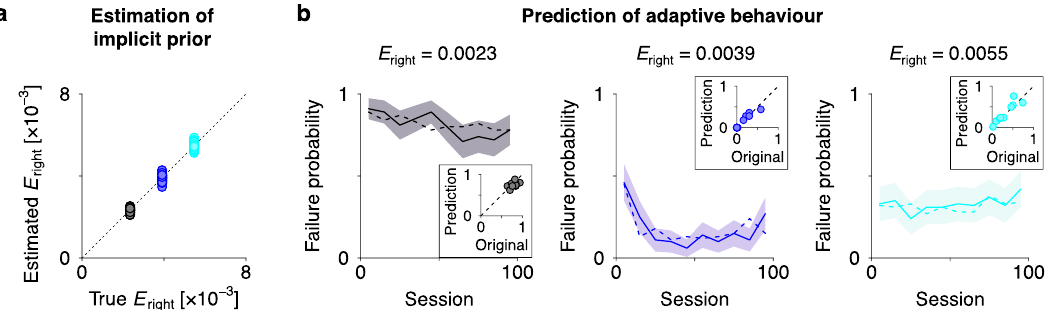
Fig. 5 Estimation of implicit priors enables the prediction of subsequent learning. a Estimation of implicit prior E right — encoded by threshold factor ψ — under three different prior conditions (black, blue and cyan; c.f., Fig. 4). Here, ψ was estimated through Bayesian inference based on sequences of neural ; E ; E activity, obtained with ten distinct mazes. Then, E was computed by ln E ¼ ψ for each of 64 elements. The other 192 elements of E 1 (i.e. E ) right 1 left up down 1 were also estimated. The sum of all the elements of E 1 was normalised to 1. b Prediction of the learning process within previously unexperienced, randomly generated mazes. Using the estimated E , we reconstructed the computational architecture (i.e. neural network) of the agent. Then, we simulated the adaptation process of the agent ’ s behaviour using the reconstructed neural network and computed the trajectory of the probability of failure to reach the goal within T ¼ 2 ´ 10 4 time steps. The resulting learning trajectories (solid lines) predict the learning trajectories of the original agent (dashed lines) under three different prior conditions, in the absence of observed neural responses and behaviours. Lines and shaded areas indicate the mean and standard error, respectively. Inset panels depict comparisons between the failure probability of the original and reconstructed agent after learning (average over session 51 – 100), within ten previously unexperienced mazes. Refer to Methods section ‘ Data analysis ’ for further